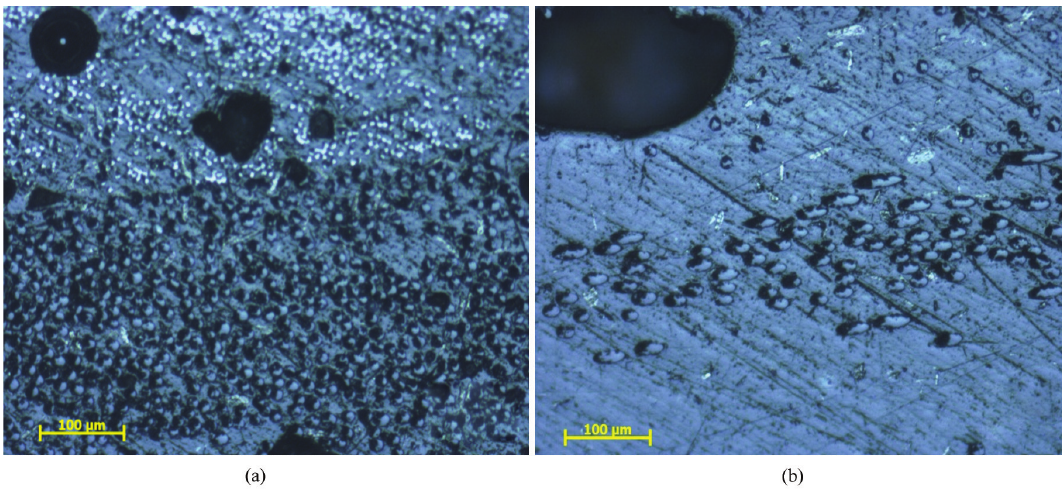
Figure 2. Uneven distribution of fibers along the composite pipe wall. a) Fiber rich region, and b) Resin rich areas and large voids can be observed.